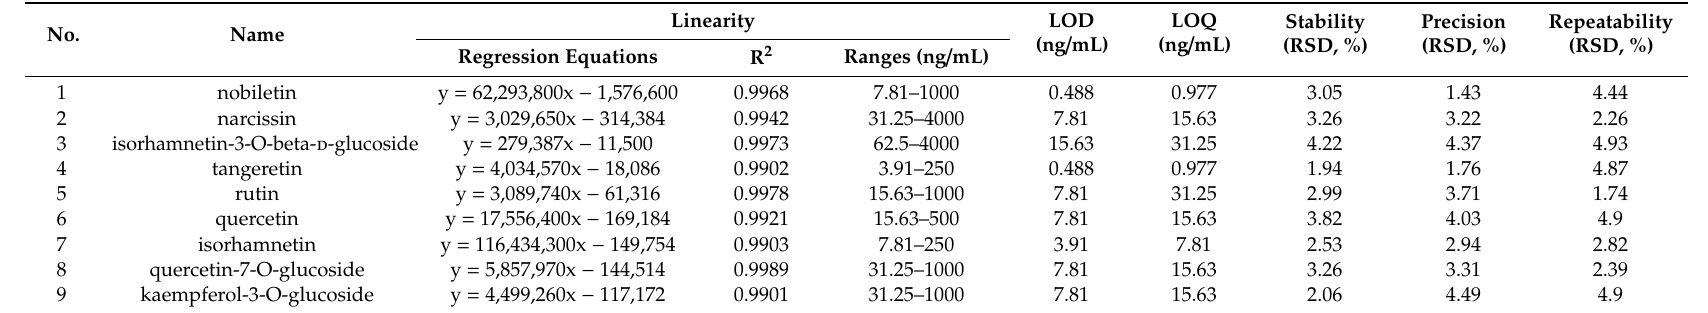
Table 3. Method validation results including linearity, LOD, LOQ, stability, precision and